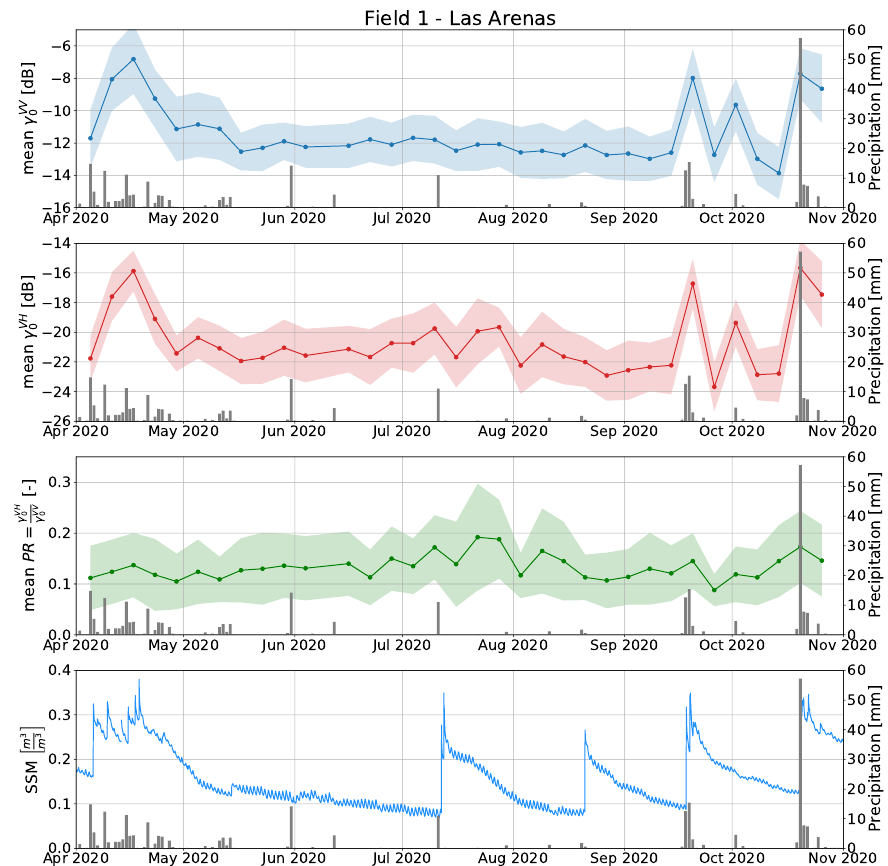
Figure 6. Time series of mean SAR parameters over field 1 of Las Arenas and in situ data registered from the stations. The time series from April to October 2020 is reported. γ V V 0 in dB is represented in blue, γ V H 0 in dB is illustrated in red, PR is described with a green line, in situ soil moisture in m 3 /m 3 are shown with a light blue line and finally, the precipitations in mm are reported with gray bars. The shadows in the SAR parameters graphs represent the standard deviation over the field 1 for every date.